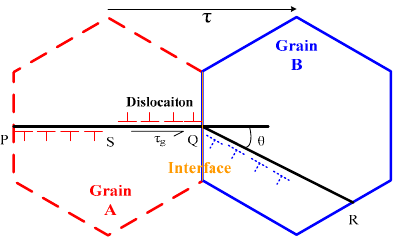
Figure 9. Dislocation accumulation model for plastic deformation.